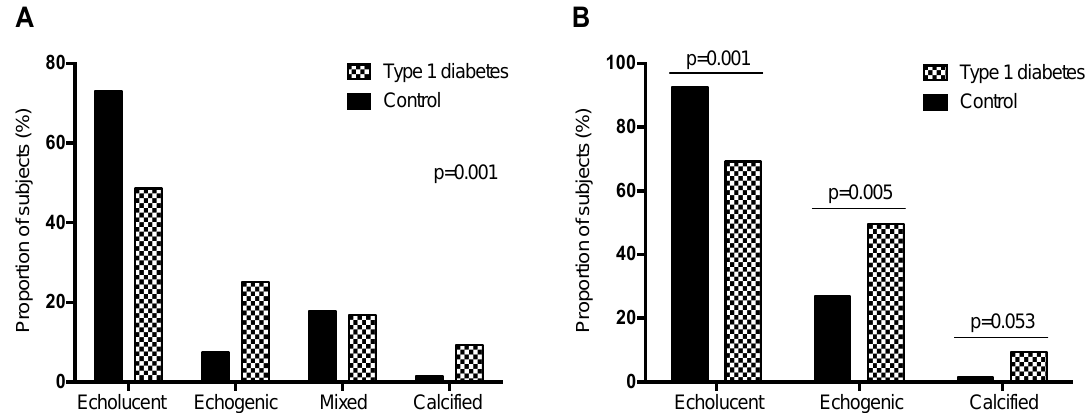
Figure 1. Atherosclerotic plaque type. ( A ) Proportion of patients with different types of atherosclerotic plaques (only echolucent, only echogenic, mixed of echolucent and echogenic plaques, and calcified with or without another plaque type). ( B ) Proportion of patients with different types of atherosclerotic plaques (at least one echolucent plaque, at least one echogenic plaque, and at least one calcified plaque).